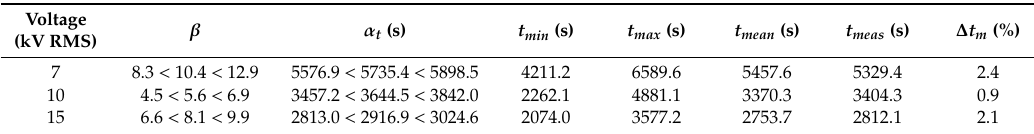
Table 4. Weibull distribution parameters for the time to breakdown. Typical measured breakdown time t meas taken from